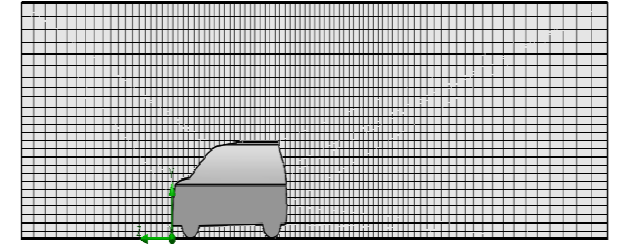
Fig. 9. Mesh generated at fine level in SolidWorks